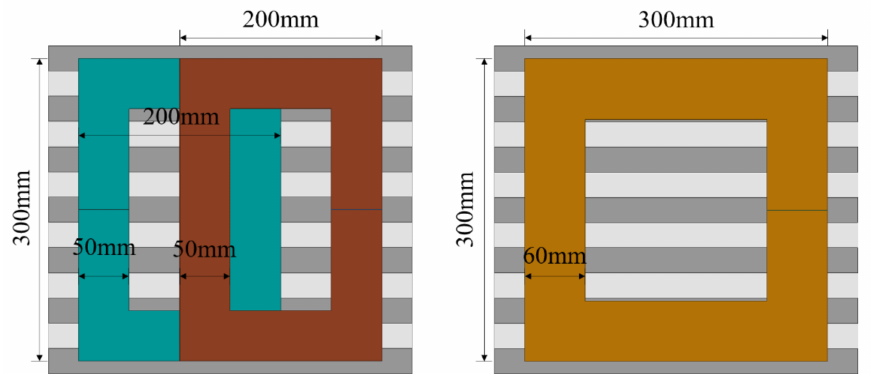
Figure 9. Design scheme of magnetic coupling structure.